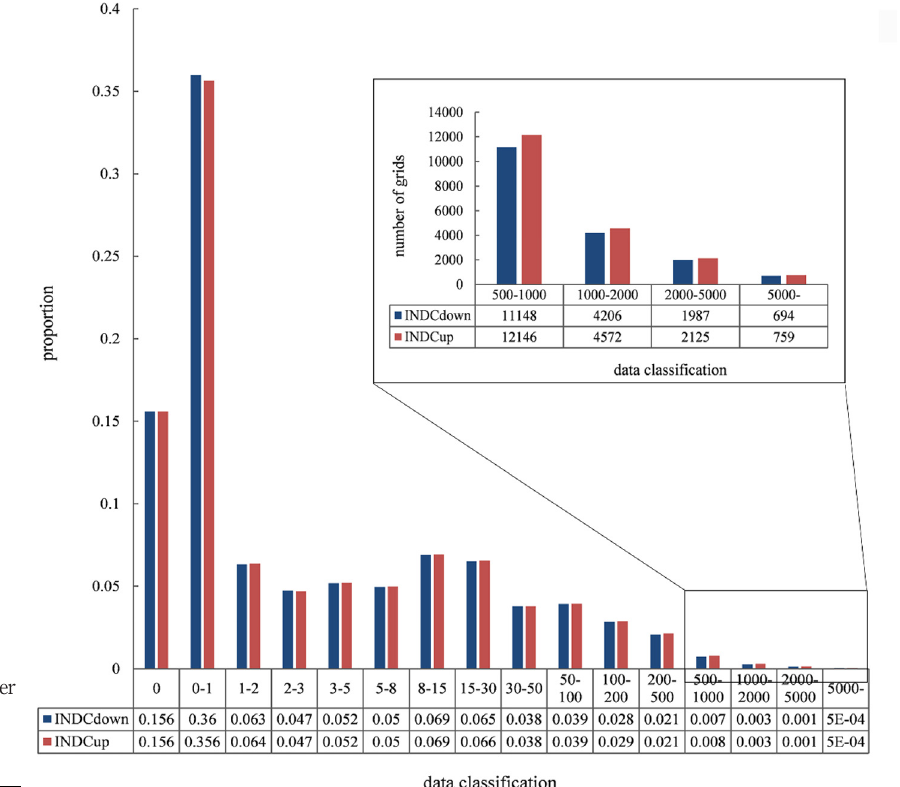
Figure 8. Comparison of the grid number of the global carbon emission levels under conditional and unconditional